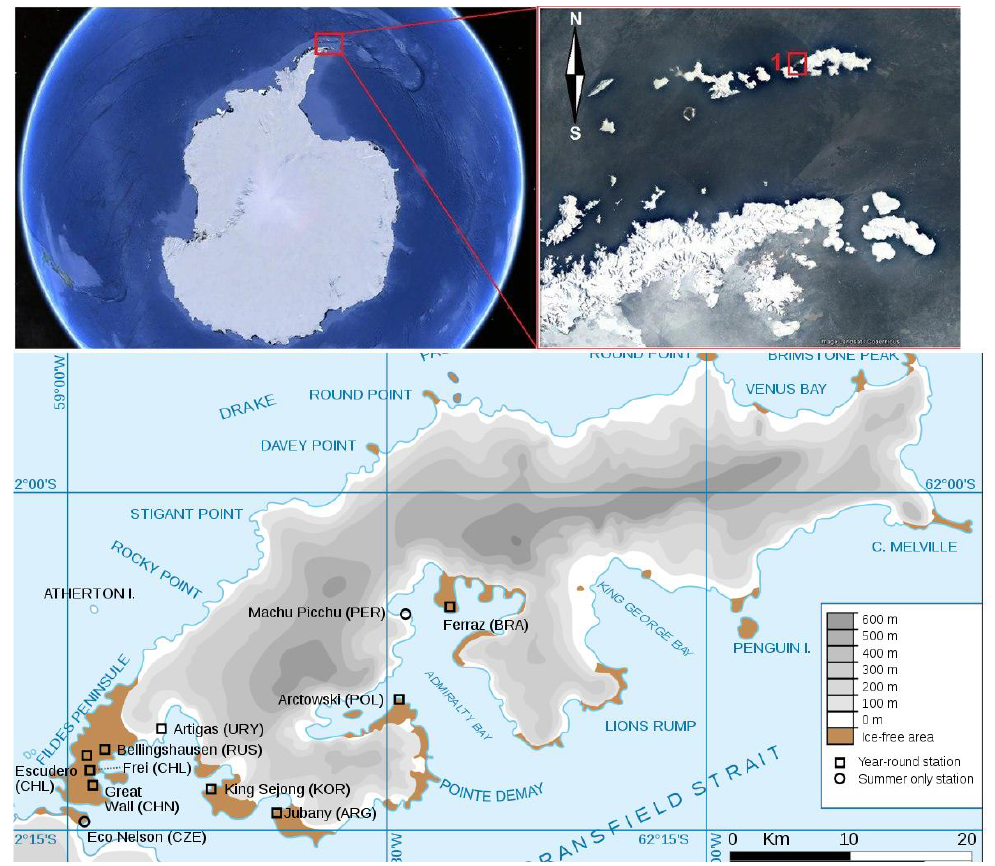
Figure 1. Location of the Fildes